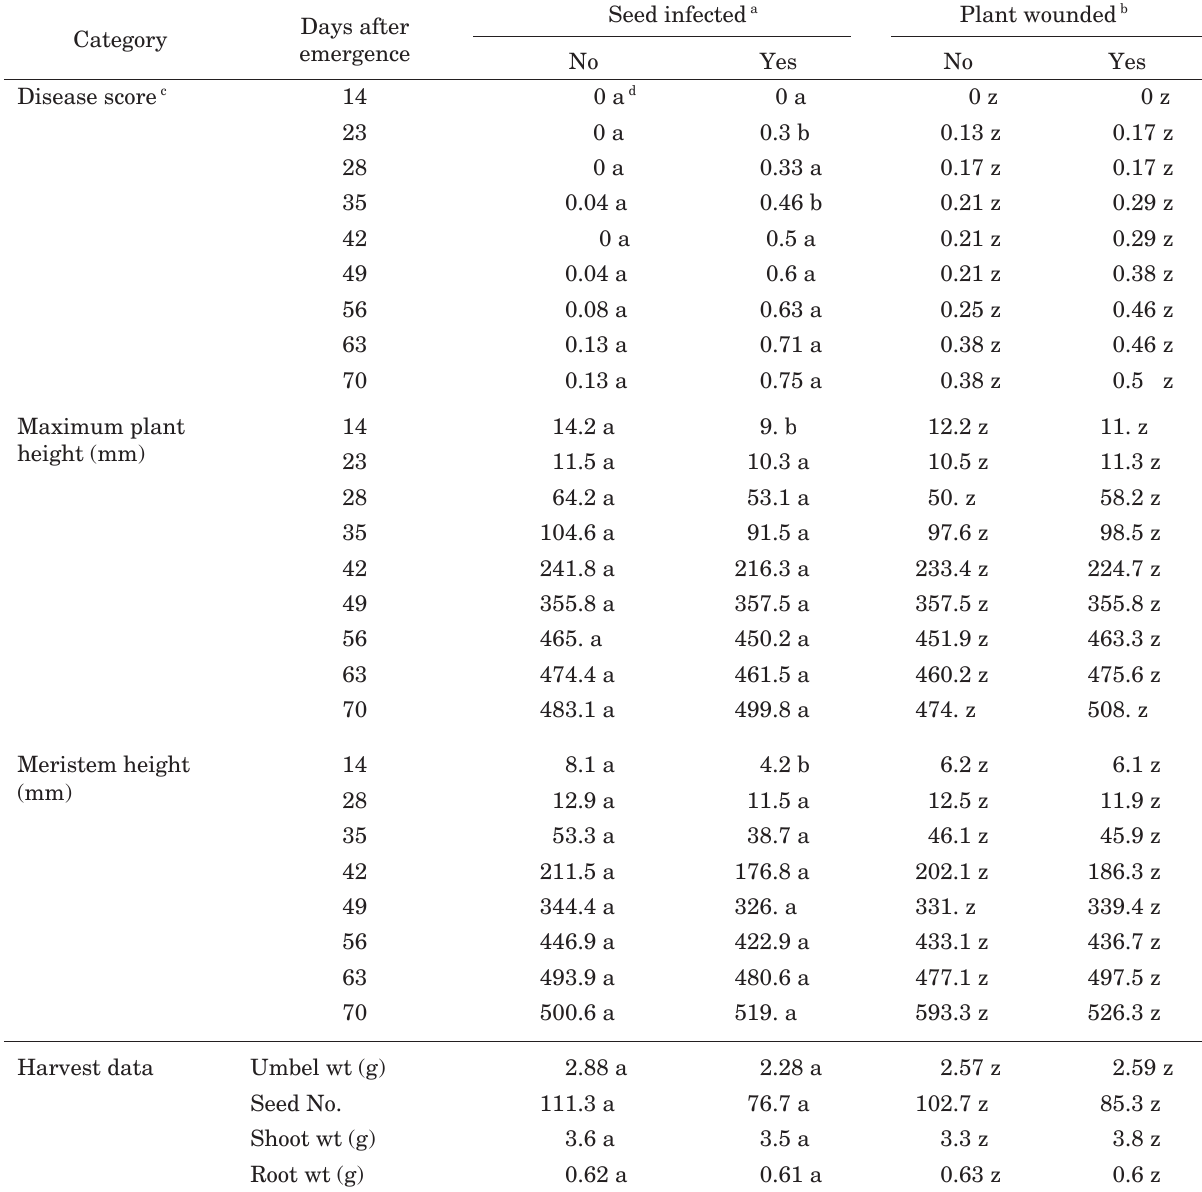
Table 2. Effect of seed contamination with Pseudomonas syringae pv. c oriandricola and subsequent wounding of the plant crown in inducing bacterial blight of